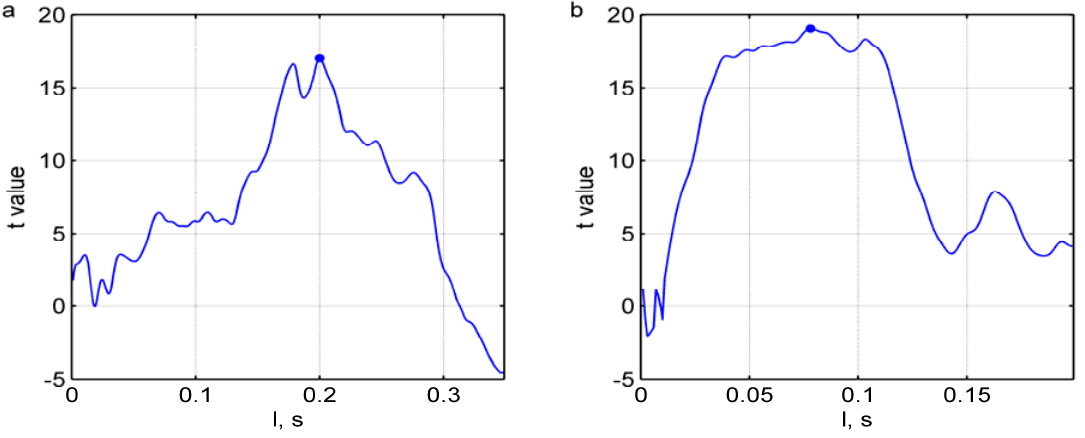
Figure 6. Optimal linear regression length. Experimental statistic (t-value) depends on the applied linear regression length and reveals an optimum duration, l , here shown in a optim typical example for ( a ) the PMC (blue dot; l = 200 ms, t = 17.0, p < 0.001) and ( b ) the optim VC condition (blue dot; l = 78 ms, t = 19.12, p < 0.001). Note that panels are optim scaled